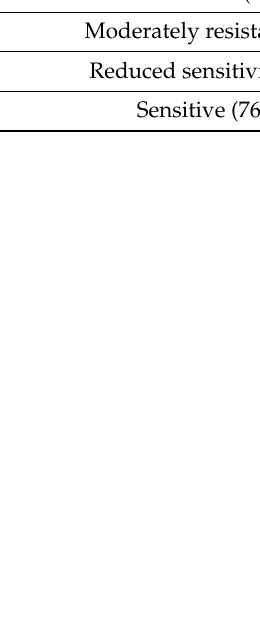
Sensitivity to Azoxystrobin with Four Key Relative Growth Inhibition (RGI) (%)